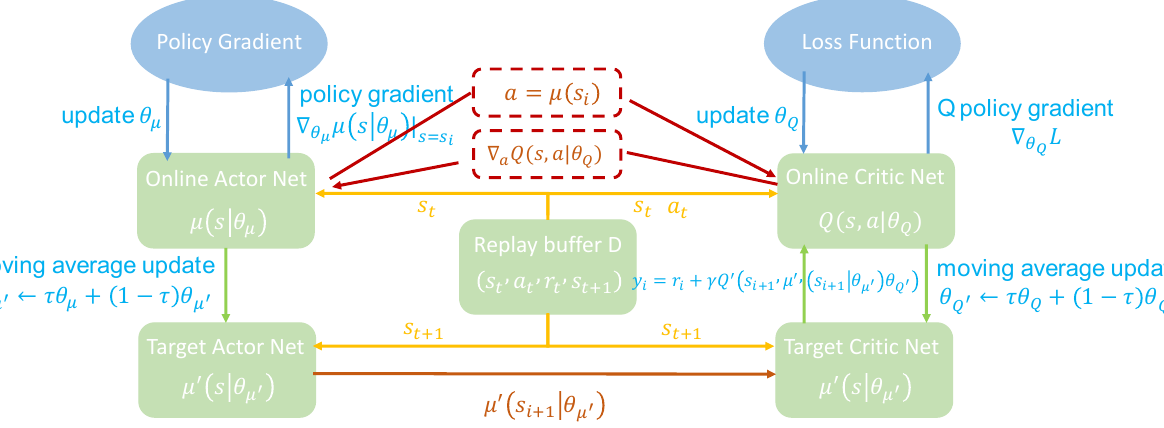
Figure 2. Schematic diagram of the principle of deep deterministic policy gradient.